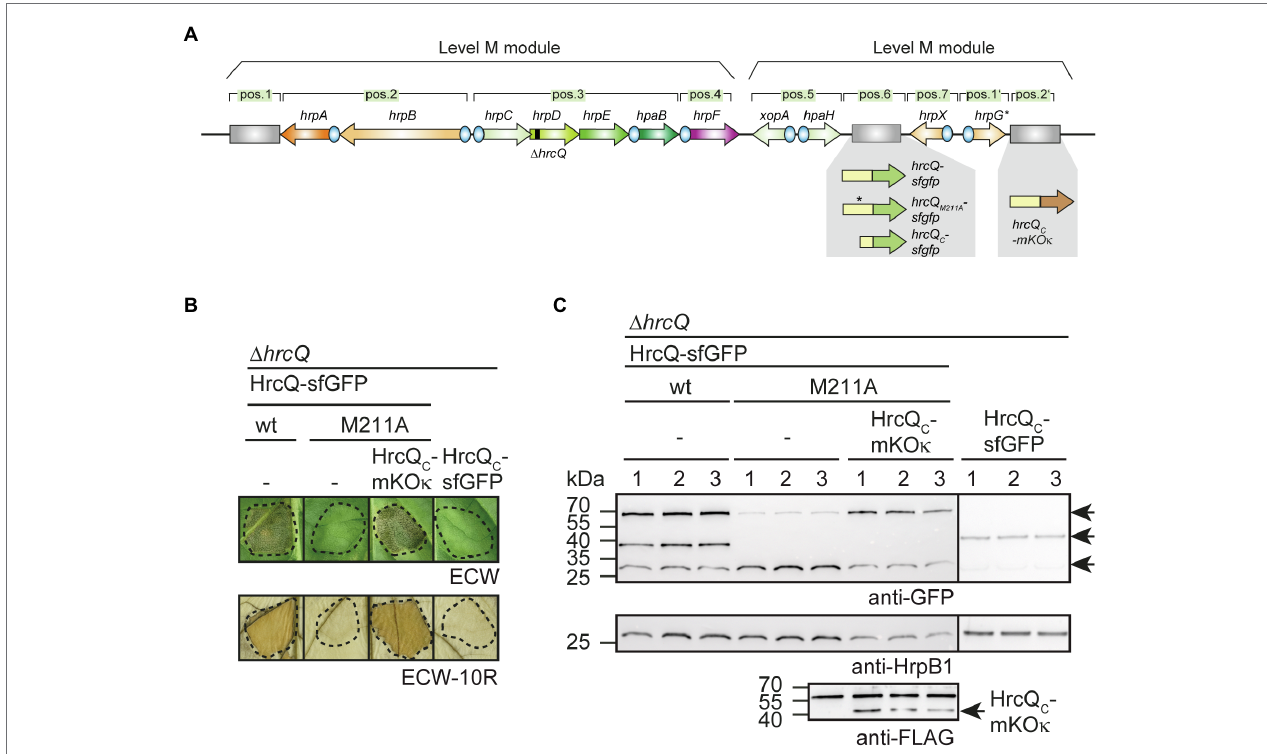
FIGURE 7 | Analysis of fluorescent HrcQ and HrcQ C fusions. (A) Schematic representation of the modular T3S gene cluster construct. Genes are represented by arrows, promoters by blue circles. Grey rectangles represent dummy modules that were replaced by reporter fusions such as hrcQ-sfgfp , hrcQ M211A -sfgfp , and hrcQ C -mKO κ as indicated. The deletion in hrcQ is represented by a black rectangle. The names of single operons and genes are given above the arrows. The constructs were assembled in different steps using the Golden Gate-based modular cloning technique as described previously (Hausner et al., 2019). Specific overhangs of gene or operon modules determined their positions (pos.) in the final level P constructs which were assembled from two level M modules as indicated. (B) Complementation studies with fluorescent HrcQ fusions. Strain 85* ∆ hrp_ fs HAGX with plasmids containing the modular T3S gene cluster with a deletion in the native hrcQ gene ( ∆ hrcQ ) and including accessory and regulatory genes as depicted in (A) was used for the experiments. The modular T3S gene cluster constructs encoded HrcQ-sfGFP (wt), HrcQ M211A -sfGFP (M211A) or HrcQ C -sfGFP at position 6 and HrcQ C -mKO κ at position 2 ' of the modular construct (depicted in A ) as indicated and bacteria were infiltrated into leaves of susceptible ECW and resistant ECW-10R pepper plants. Dashed lines indicate the infiltrated areas. Disease symptoms were photographed 8 dpi. For the better visualization of the HR, leaves were bleached in ethanol 2 dpi. (C) Immunological detection of fluorescent HrcQ fusions. Three transconjugants (labeled 1, 2, and 3) of each strain described in (B) were cultivated in minimal medium (T3S-permissive conditions), and cell extracts were analyzed by immunoblotting using antibodies specific for GFP and HrpB1. HrcQ C -mKO κ contains a C-terminal FLAG epitope and was detected using a FLAG- specific antibody. The signals corresponding to the size of HrcQ-sfGFP, HrcQ C -sfGFP, and a GFP cleavage product are indicated by arrows in the upper blot. The arrow in the lower blot indicates the signal corresponding to the size of HrcQ C -mKO κ . The additional signal at the size of approximately 60 kDa presumably results from unspecific binding of the antibody and is also detected in protein extracts which do not contain FLAG epitope-tagged proteins. Experiments were performed three times with similar